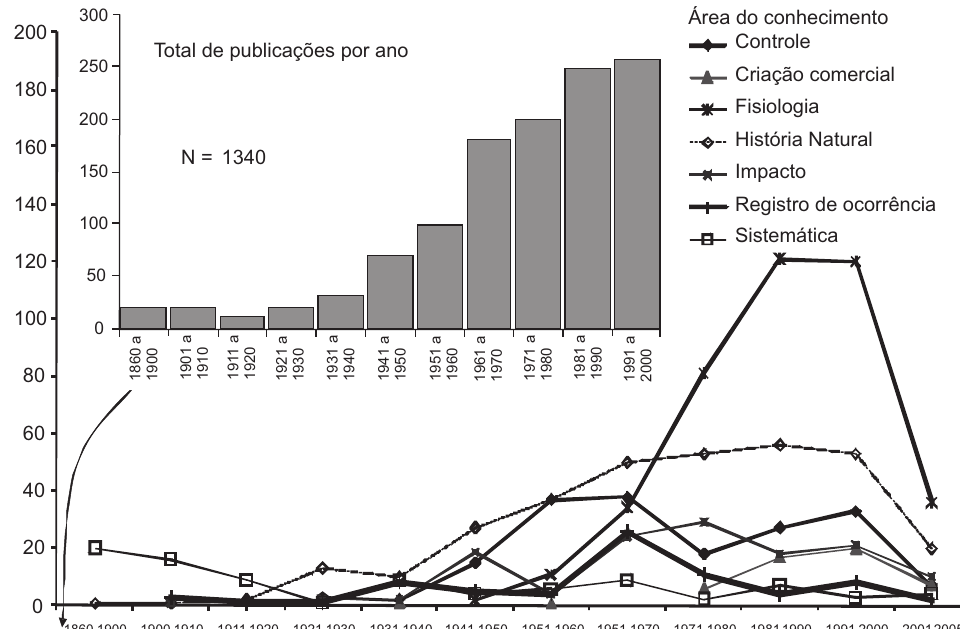
Figura 1. Total de publicações e número de publicações por área do conhecimento em cada